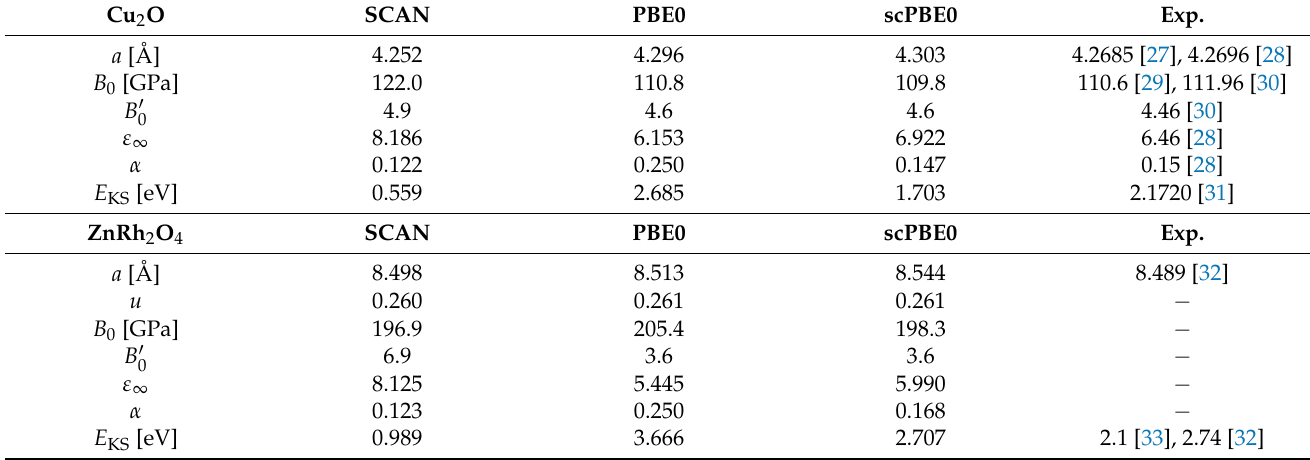
Figure 1. Upper panels : total energy (in eV) with respect to the unit cell volume for Cu 2 O ( left panel ) and ZnRh 2 O 4 ( right panel ) calculated by means of the SCAN (black) PBE0 (red), and scPBE0 (green) exchange and correlation functionals, respectively. The dashed orange lines refer to the experimental data summarised in Table 1. Lower panels : convergence for the dielectric constant ε ∞ is obtained after four steps in the additional self-consistency cycle of the scPBE0 exchange and correlation functional. For comparison, the black diamonds and dashed orange line depict the SCAN calculated ε ∞ and experimental data summarised in Table 1. Table 1. Ground state structural properties for Cu 2 O and ZnRh 2 O 4 for different exchange and correlation functionals in comparison to experimental data. Shown are the lattice constants a [Å], the internal anion displacement parameter u (for ZnRh 2 O 4 ), the bulk modulus B 0 [GPa] and its pressure derivative B (cid:48) , the calculated dielectric constant ε ∞ and the 0 corresponding α value, and the Kohn–Sham energy band gap E KS [eV],